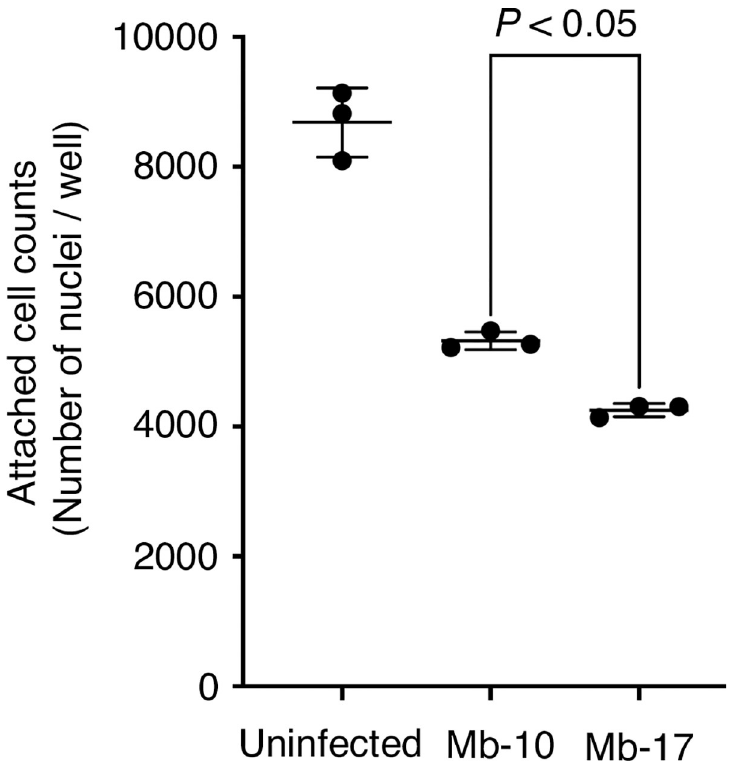
Fig 7. Attached-cell counts of human THP-1 macrophages after infection with M . abscessus subsp . abscessus Mb- 10 and Mb-17 isolates. Attached-cell counts of human THP-1 macrophages at 48 h after infection with M . abscessus subsp. abscessus Mb-10 or Mb-17 cells at a multiplicity of infection of 50. The number of nuclei of macrophages attached to the well was calculated using High-Content Imaging System Operetta CLS with Harmony software.